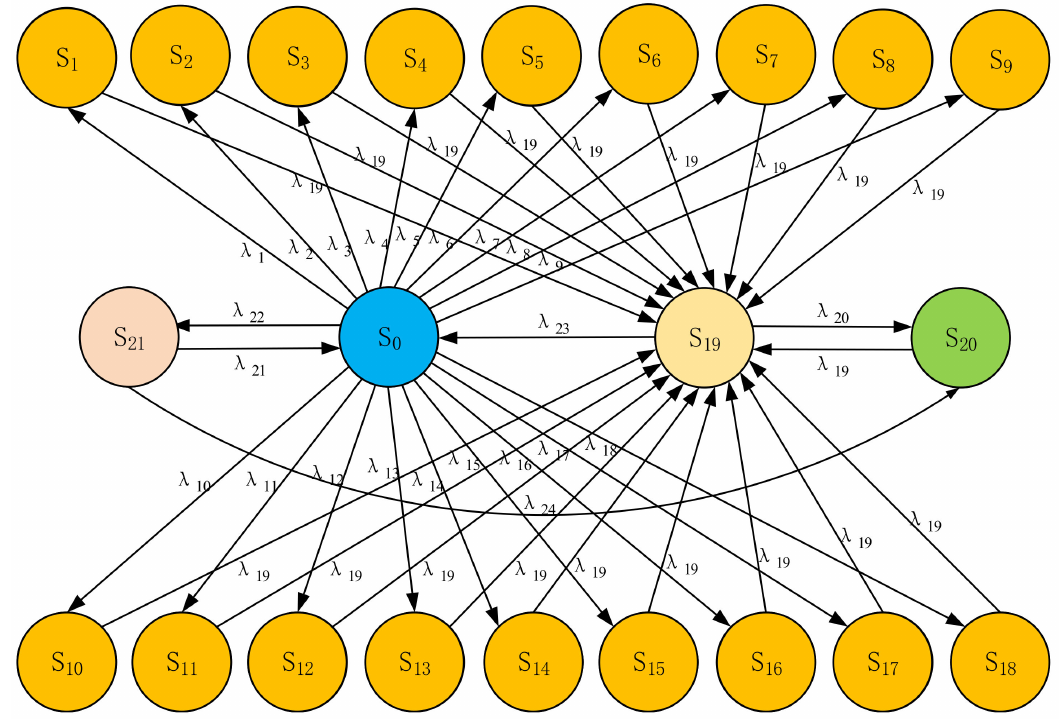
Figure 8. Markov transition diagram of subsea wellhead